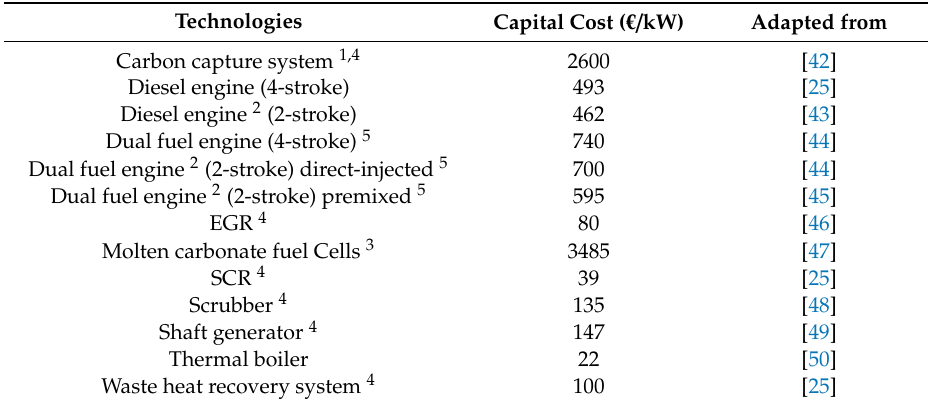
Table 5. Capital cost of